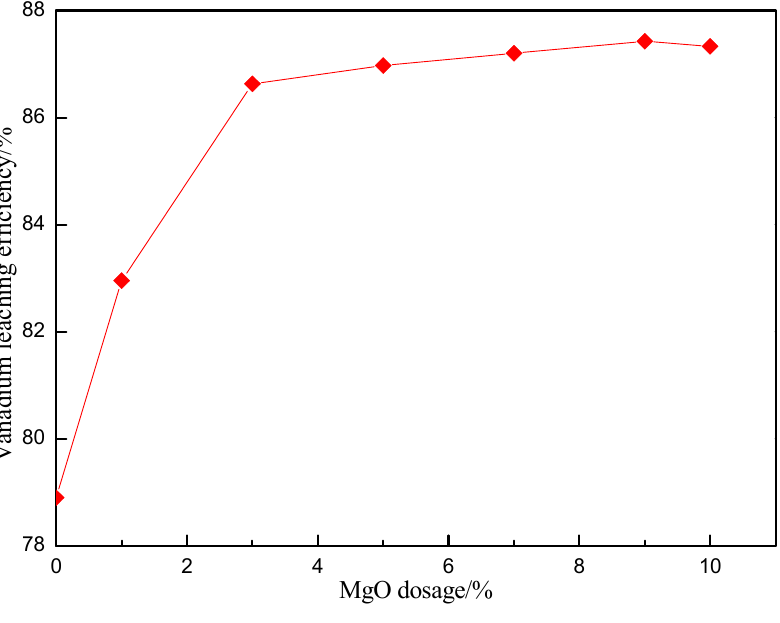
Figure 4. Effect of MgO dosage on vanadium leaching efficiency.